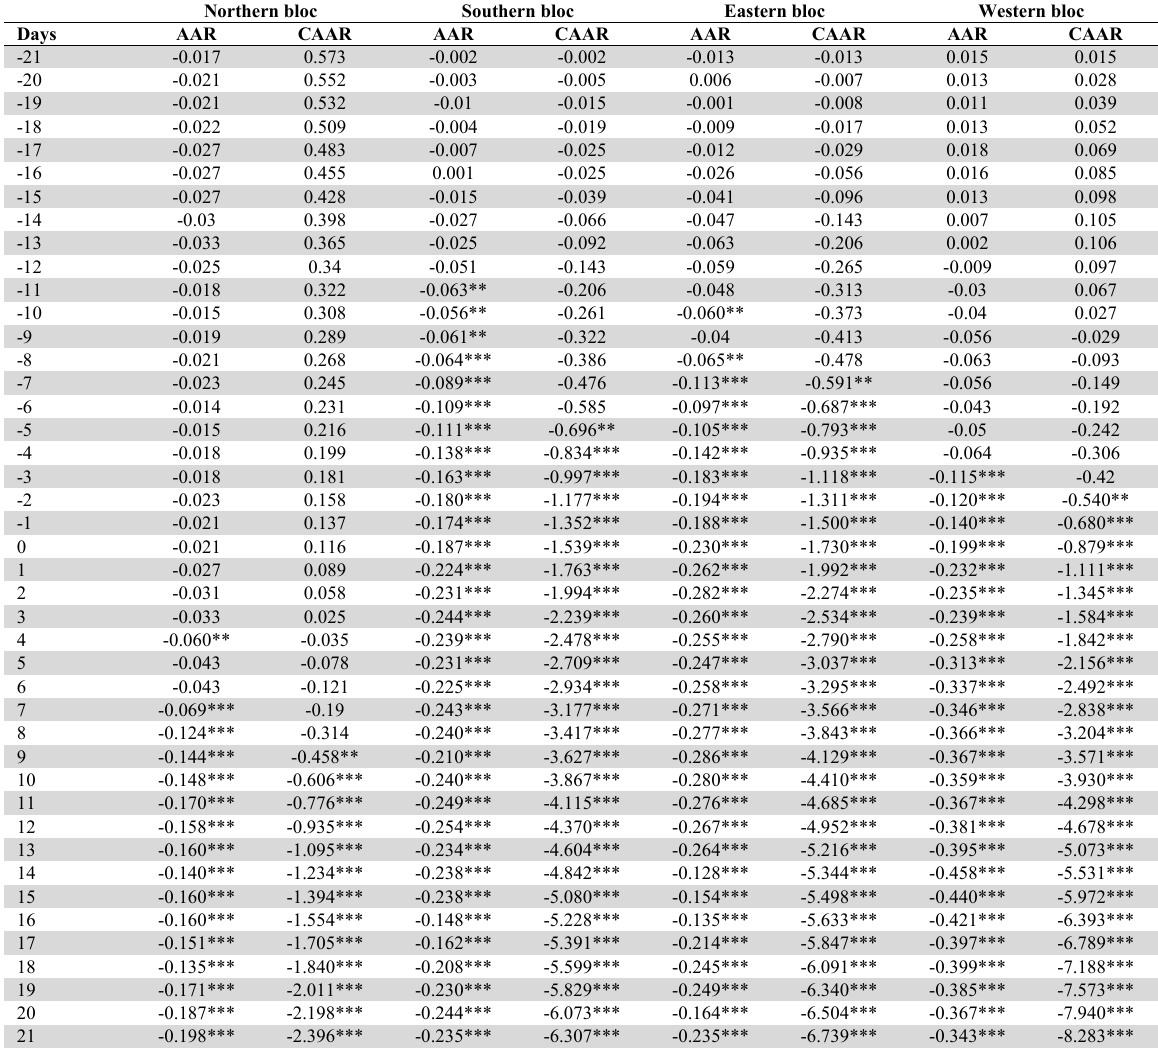
AARs and CAARs 21 days before and 21 days after the event of confirmed COVID-19 infections Northern bloc Southern bloc Eastern bloc Western bloc